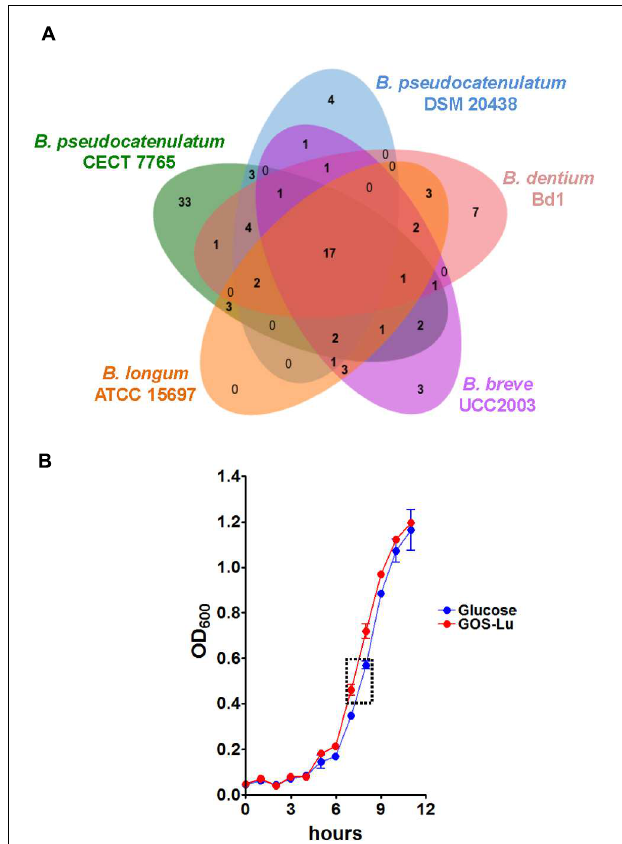
FIGURE 2 | Bifidobacterium pseudocatenulatum CECT 7765 and carbohydrate metabolism. (A) Venn diagram showing the strain-specific and shared CAZy families among five Bifidobacterium species. (B) Growth curve comparison between B. pseudocatenulatum CECT 7765 cultures using Glucose (blue line) or GOS-Lu (red line) as carbon source. Growth was monitored measuring OD 600 at 60 min intervals. The OD 600 values are presented as a mean of three independent replicates ( ± SEM). The dashed square indicates the growth window for the exploratory transcriptome and qPCR